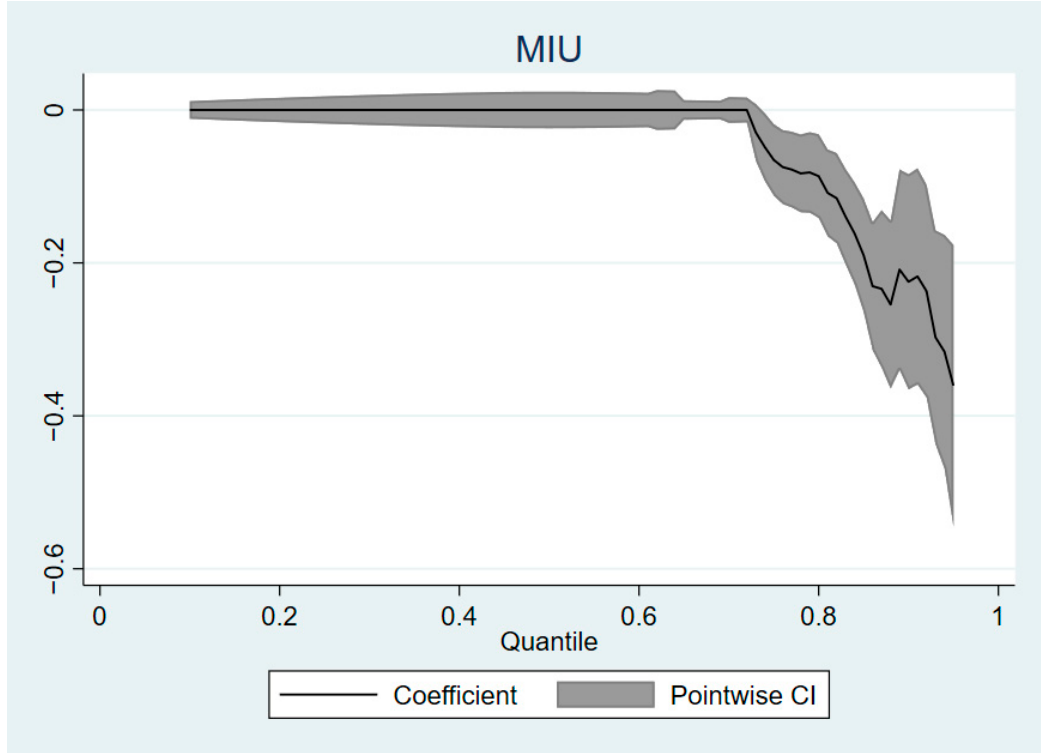
Figure 2. Quantile regression coefficient diagram.